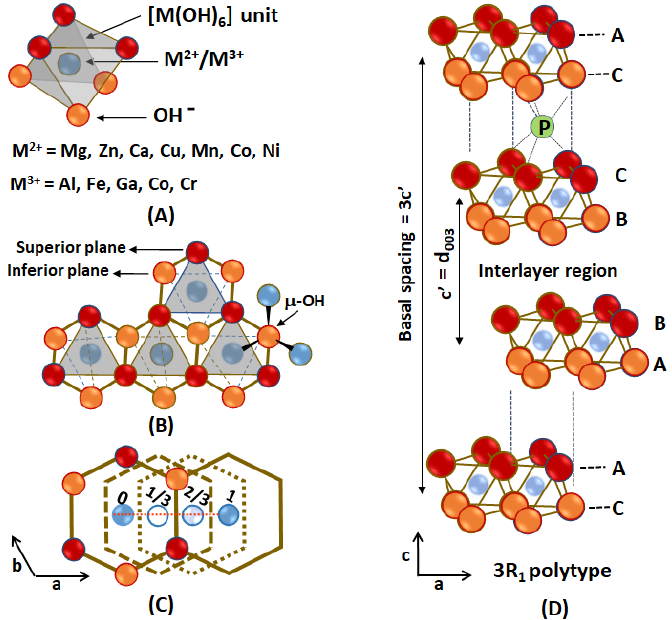
Figure 7. LDH structural aspects: ( A ) [M(OH) 6 ] units, ( B ) edge-sharing among octahedra, ( C ) se- quence of the layers stacking and ( D ) face-to-face arrangement of the layers. Uppercase symbols A, B, and C represent hydroxide ion positions; P indicates a prismatic site.